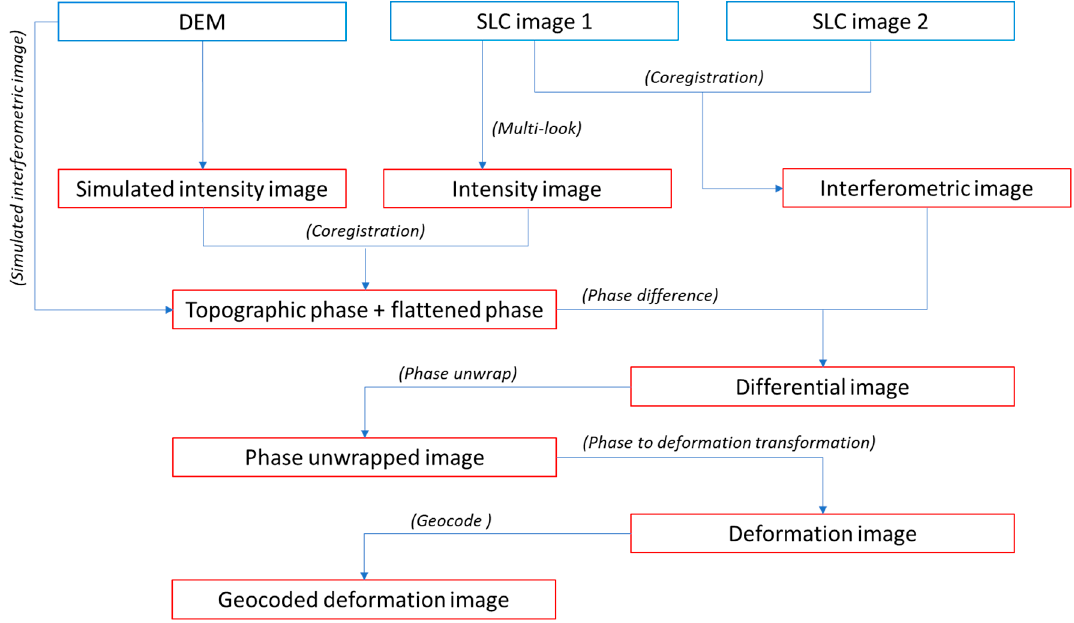
Figure 1. Two-pass differential method processing steps, including the digital elevation model (DEM) and single look complex (SLC).